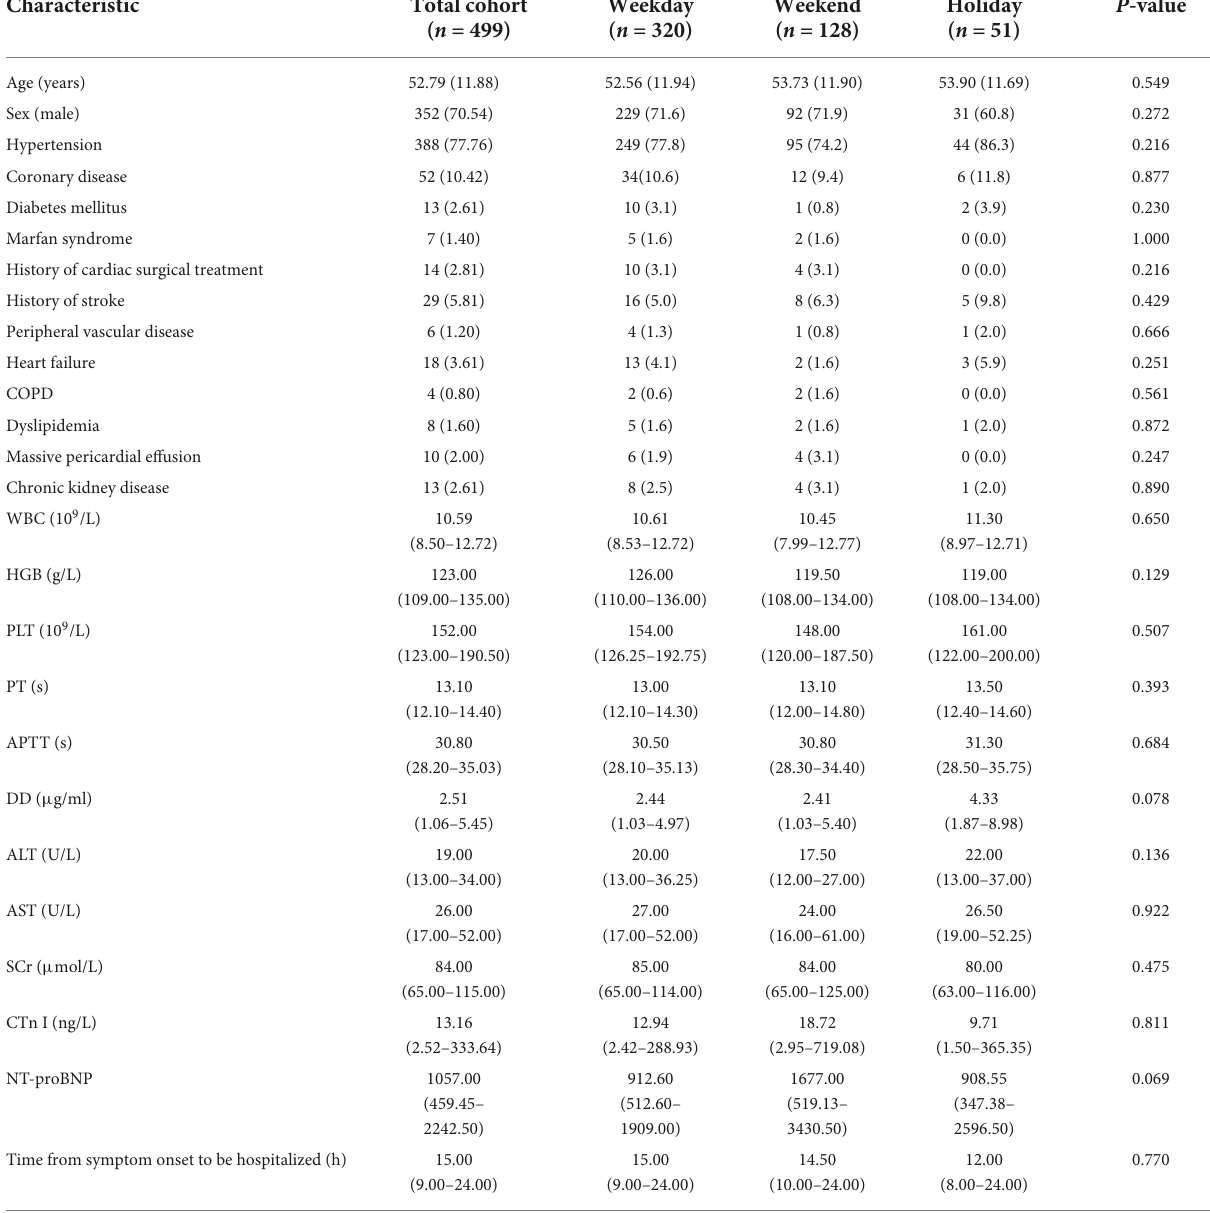
TABLE 1 Preoperative patient